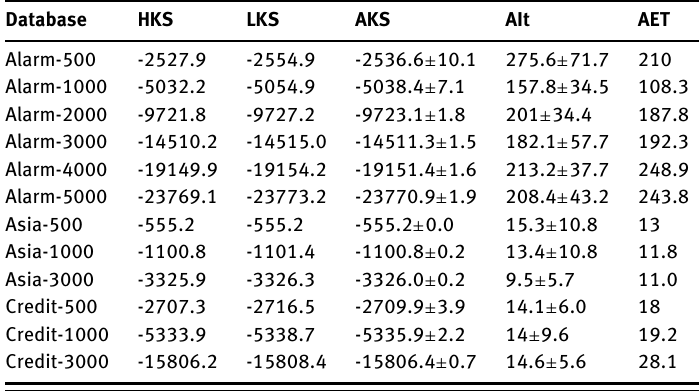
Table 2. The k 2 score, number of iterations and running time of BVD-MPSO-BN on different networks